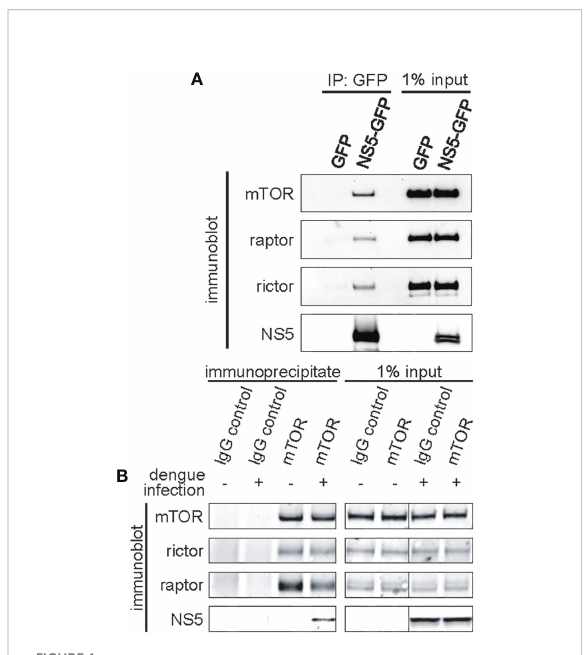
FIGURE 1 Dengue NS5 interacts with mTORC1 and mTORC2. (A) , Immunoprecipitation of NS5-GFP fusion protein identi fi es mTORC1 and mTORC2 interacting proteins. 293FT cells were transfected with expression plasmids encoding GFP or NS5-GFP fusion protein, and NS5-GFP was af fi nity captured from the cell lysate using anti-GFP nanobodies. 50% of the eluates or 1% of the input lysate were then assayed by western blot analysis with the indicated antibodies. (B) , mTOR interacts with NS5 during dengue infection. HepG2 cells were infected with dengue virus, serotype 2, at an MOI of 4. mTOR was immunoenriched from the lysate using anti-mTOR antibodies. Separately, nonspeci fi c IgG was used as an immunoprecipitation control. 50% of the eluates or 1% of the input lysate were then assayed by western blot analysis with the indicated